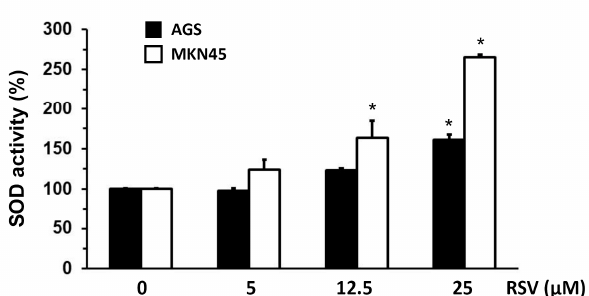
Figure 3. Effect of RSV on SOD activity in gastric cancer cell lines. AGS and MKN45 gastric cells were treated with different concentrations of RSV for 24 h (5–25 µ M). SOD activity was determined using an ELISA method in AGS (black column) and MKN45 (white column) protein extracts. Data represent means ± S.D. of three independent experiments. * p < 0.05 vs. control.